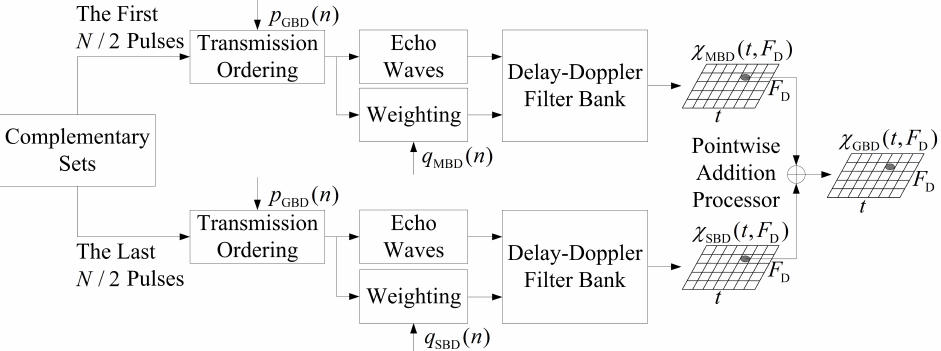
Figure 3. The schematic of the GBD